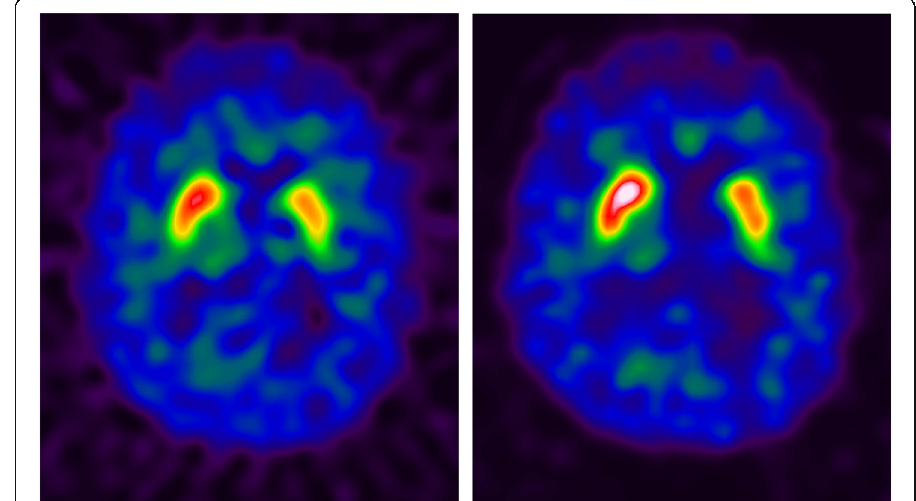
Fig. 9 Slab view (Buchert et al. 2016b) corresponding to a 63-year-old male patient showing uniformly asymmetric uptake with a reduction on the entire left striatum. Left (FBP) and right (Flash3D)